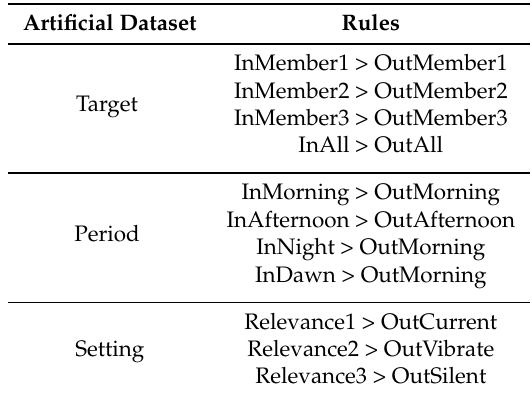
Table 5. OneR test with